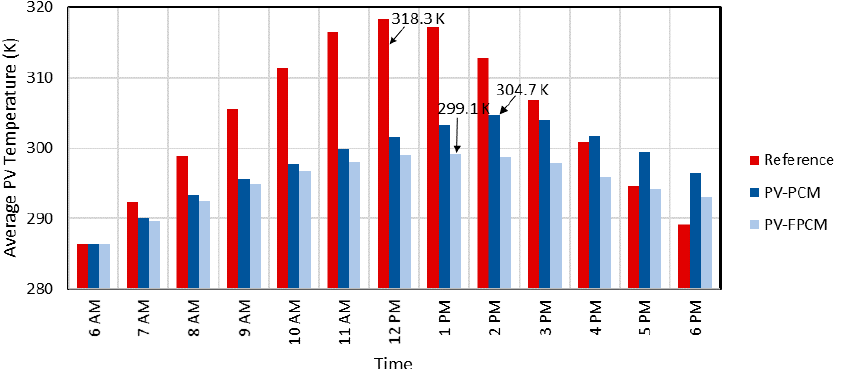
Figure 2. Average temperature of PV panel of reference system, PCM cooled system and FPCM cooled system.